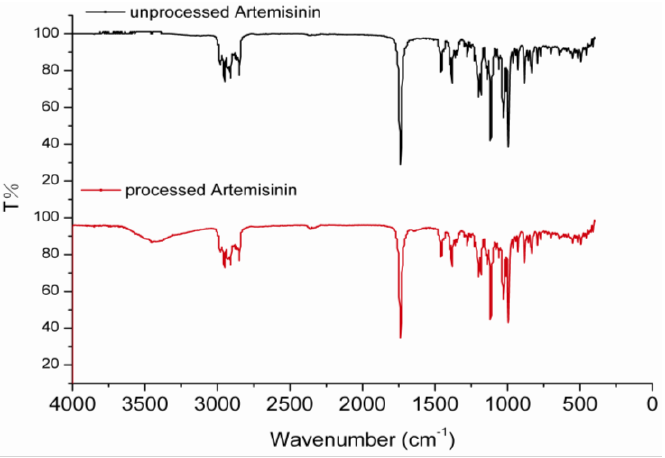
Figure 4. Comparison of artemisinin FTIR spectra before and after RESS